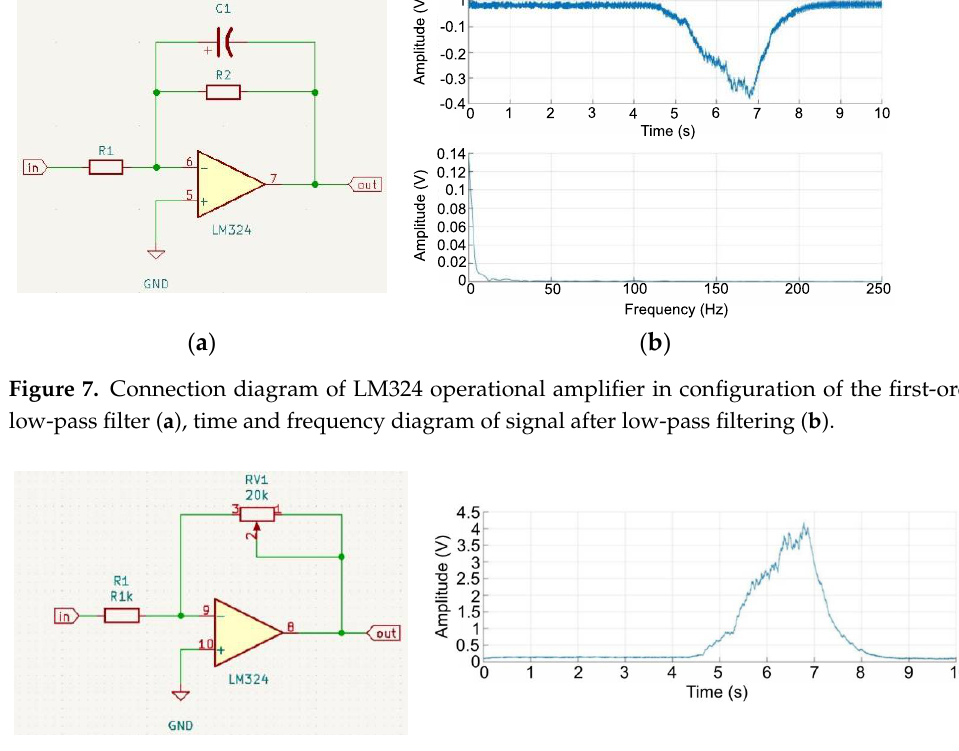
Figure 7. Connection diagram of LM324 operational amplifier in configuration of the first-order low-pass filter ( a ), time and frequency diagram of signal after low-pass filtering ( b ).